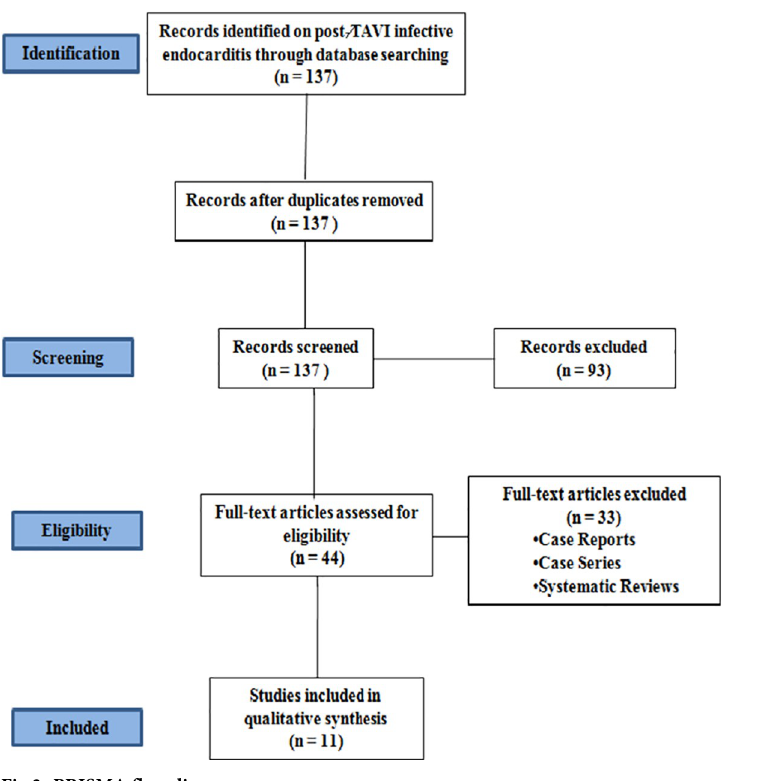
Fig 3. PRISMA flow